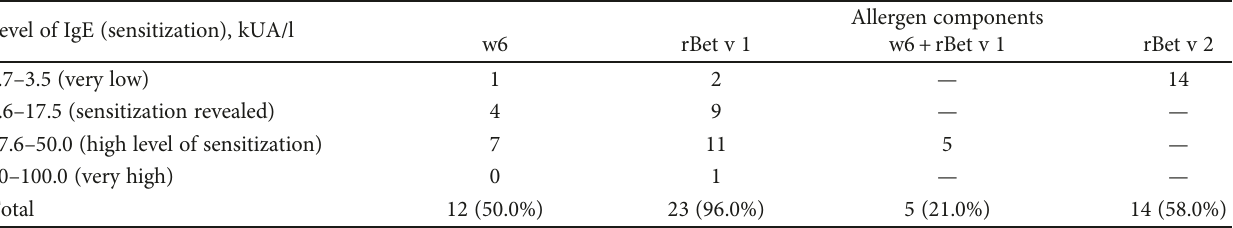
Table 3: Distribution of patients with seasonal allergic rhinitis (SAR) according to the level of sensitization to pollen allergen components of Artemisia vulgaris and birch ( N = 24 ).